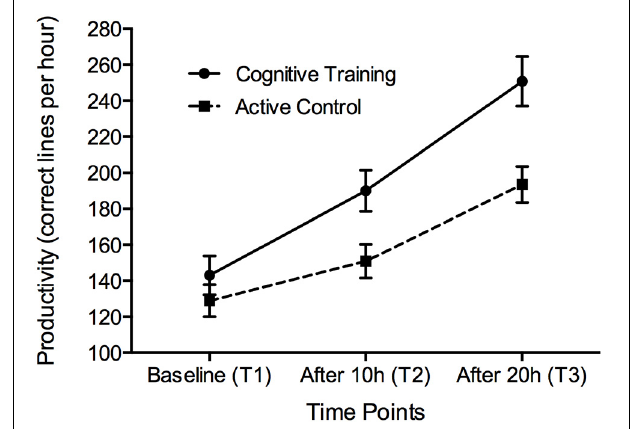
FIGURE 2 | Performance on the 60-min bookkeeping task at the three time points. Error bars represent standard error. Significant TIME X GROUP differences were observed at T2 and T3.